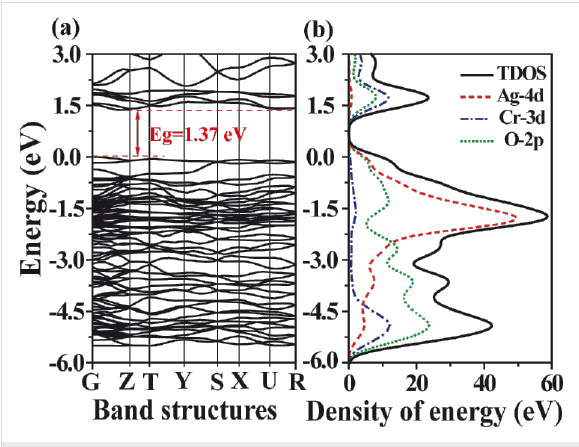
Figure 6: Band structure plots (a) and density of states (b) for Ag 2 CrO 4